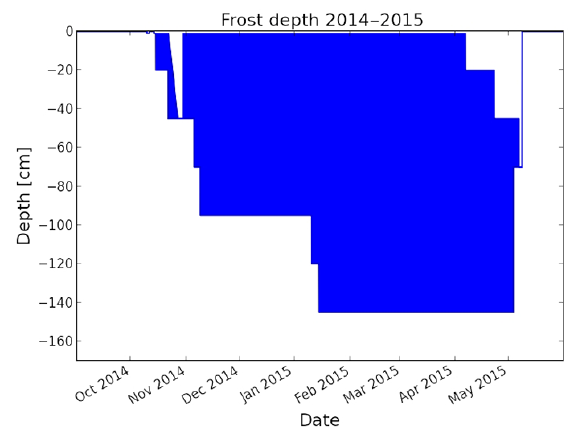
Figure 8. Frost depth data from the RWS